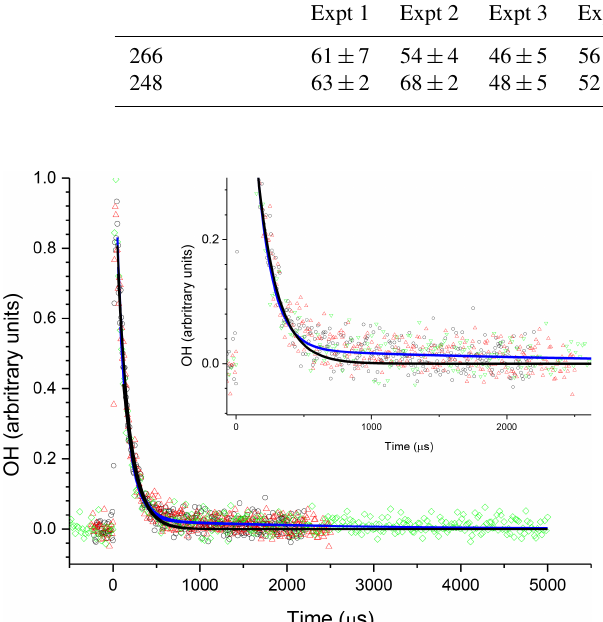
Figure 10. An example of the OH signal collected at the first de- tection axis for the reaction of OH with n -butanol ([nBuOH] ≈ 1 . 4 × 10 15 molec.cm − 3 , at 616K; black, red, and green points are three consecutive decays collected with differing timescales. The black line represents the least-squares fits to an exponential de- cay ( k (cid:48) 1 , 1st = ( 6780 ± 380 ) s − 1 ), with the blue line representing a bi-exponential fit ( k 1 , biexp , 1st = ( 8190 ± 180 ) s − 1 )). Both lines are global fits to the three experiments.